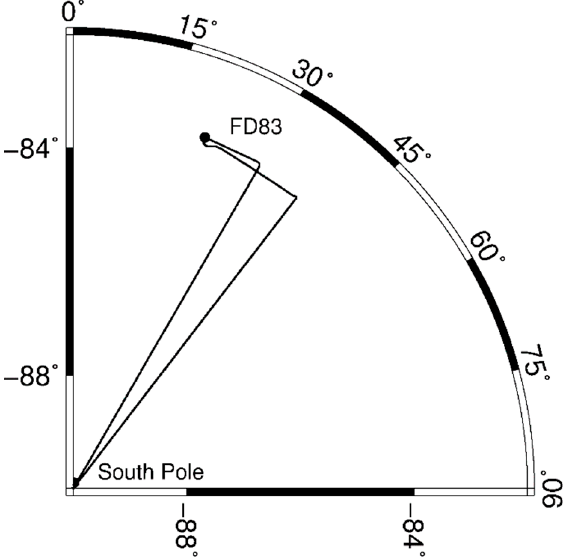
Figure 7. The trajectory of this flight with the latitude shown on the radius and the longitude on the arc. FD83 is the reference station.